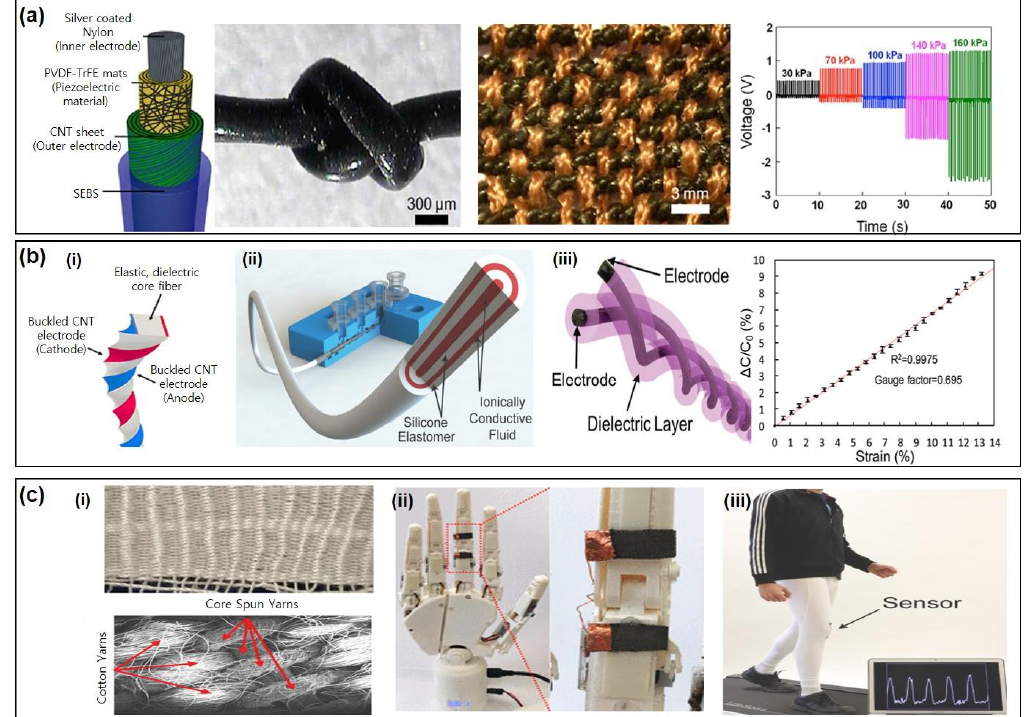
Figure 2. Fiber-based piezoelectric and capacitive tactile sensors. ( a ) Piezoelectric tactile fiber sensor was fabricated with an electrospun PVDF-TrFE fiber wrapped with silver-coated nylon yarn. This fiber sensor was flexible enough to be yarn and made into a textile. Reproduced with permission from [43], Copyright (2015), Wiley. ( b ) Core-spinning with silver fiber and cotton fiber. This fiber was integrated into cotton fabric. Reproduced with permission from [80], Copyright (2019), Wiley. ( c ) (i) Multicore-shell printing with dielectric elastomer and ionically conductive fluid. (ii) This fiber sensor was sewn onto pants to detect walking. Reproduced with permission from [81], Copyright (2015), Wiley. (iii) Cotton fabric based capacitive tactile sensors were attached to a robotic hand. Reproduced with permission from [80], Copyright (2020), American Chemical Society.